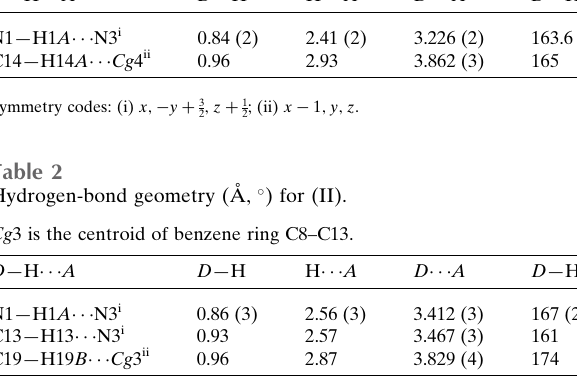
Table 1 Hydrogen-bond geometry (A˚ , (cid:3) ) for (I). Cg 4 is the centroid of the imidazole ring system N2/N3/C1–C7. D —H (cid:2)(cid:2)(cid:2) A